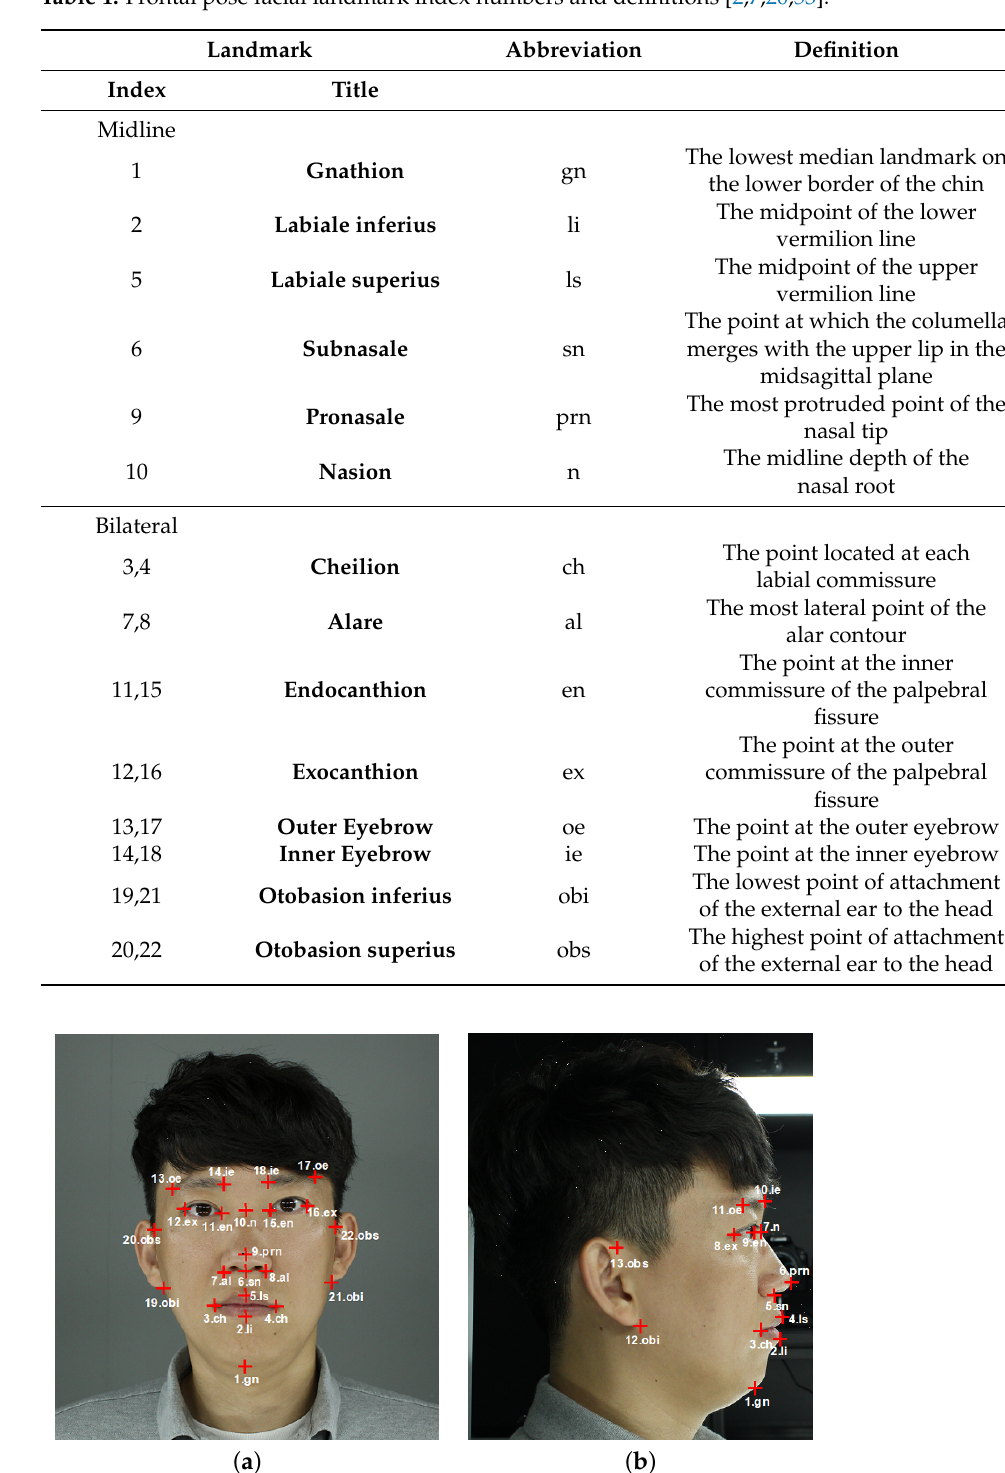
Figure 4. The location of facial landmarks: ( a ) frontal pose; ( b ) side pose. To train the facial landmark detector, the Multi-PIE database was used [54]. The Multi- PIE database is a large-scale facial database that consists of different poses, illumination conditions, and facial expressions of 337 of a variety of races, with a male-to-female ratio of 7 to 3. Figure 5 is a sample from the Multi-PIE